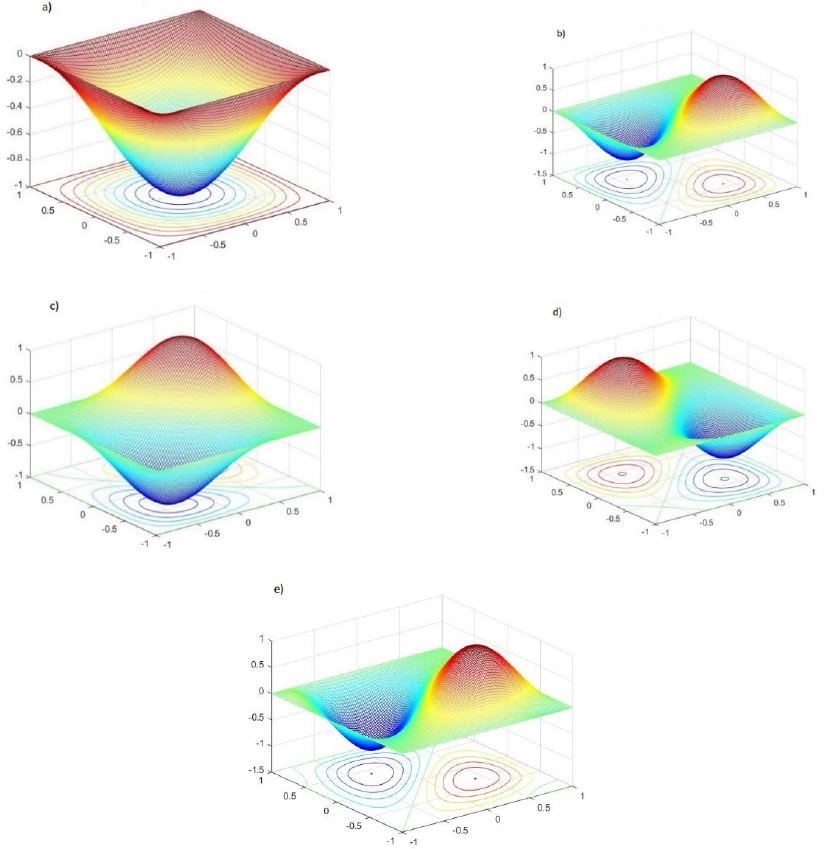
Figure 9. Vibrational modes for USFG distribution without the agglomeration effect: ( a ) 1st mode, ( b ) 2nd mode, ( c ) 3rd mode, ( d ) 4th mode, ( e ) 5th mode.